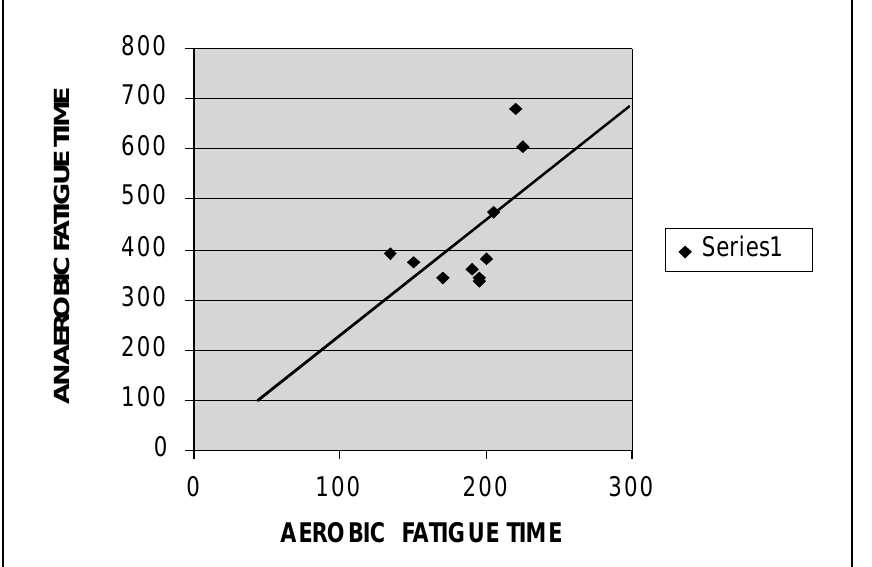
Figure 1: Correlation between anaerobic and aerobic fatigue time in the diabetic